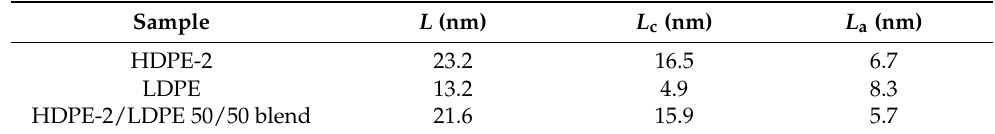
Table 5. Data of the long period ( L ), crystalline phase thickness ( L c ), and amorphous phase thickness ( L a ) obtained from the one-dimension correlation function.